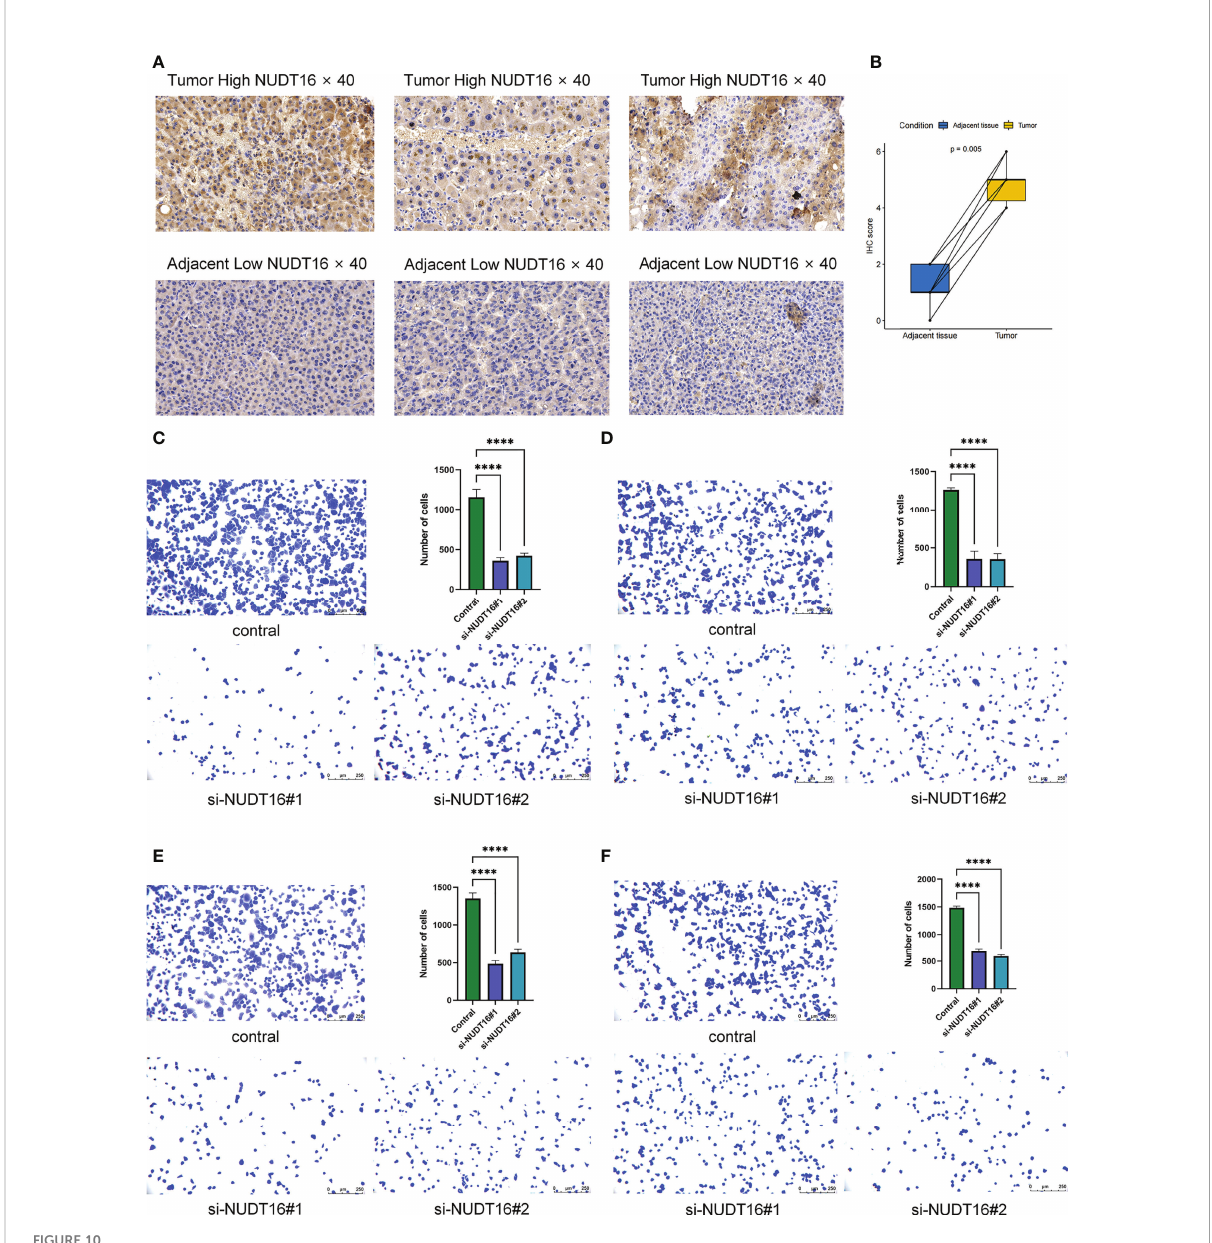
FIGURE 10 Immunohistochemical analysis of NUDT16 expression in HCC tissues and adjacent tissues and effect of NUDT16 on the adhesion ability of HCC cells. (A) High NUDT16 expression in HCC tissues at 40× magni fi cation. Low NUDT16 expression in adjacent tissues at 40× magni fi cation. (B) Comparison of NUDT16 IHC scores in HCC tissues and paired adjacent tissues. (C) Comparing the adhesion ability of Huh-7 cells to fi bronectin between control and si-NUDT16 groups. (D) Comparing the adhesion ability of Huh-7 cells to vitronectin between control and si- NUDT16 groups. (E) Comparing the adhesion ability of HepG2 cells to fi bronectin between control and si-NUDT16 groups. (F) Comparing the adhesion ability of HepG2 cells to vitronectin between control and si-NUDT16 groups. (****P< 0.